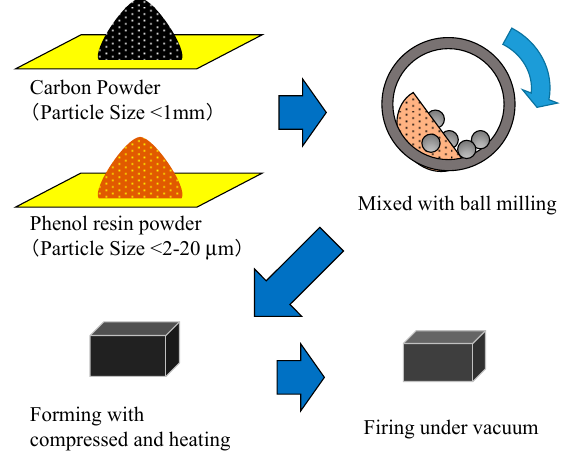
Figure 5. The process of manufacturing woodceramics. First, the carbon powder was made by mixing sawdust charcoal and phenol resin powder by ball milling. Then, the mixed powder was compressed